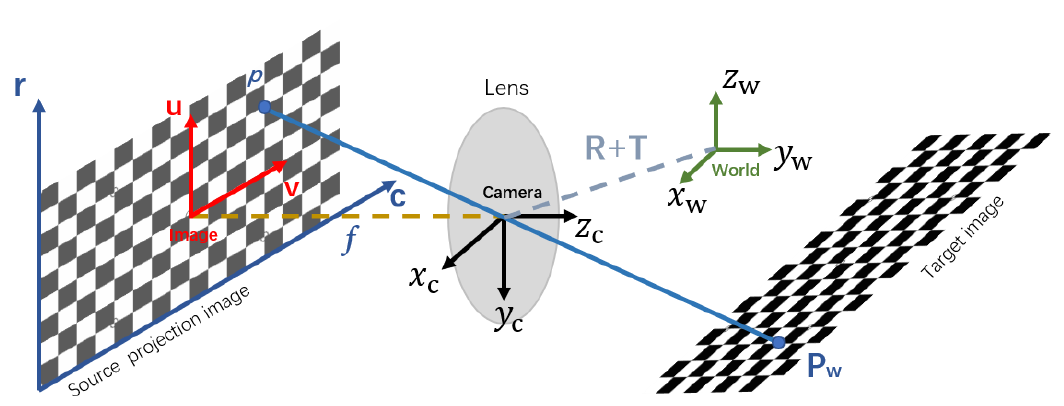
Figure 4. The inverse camera pinhole model of projector for